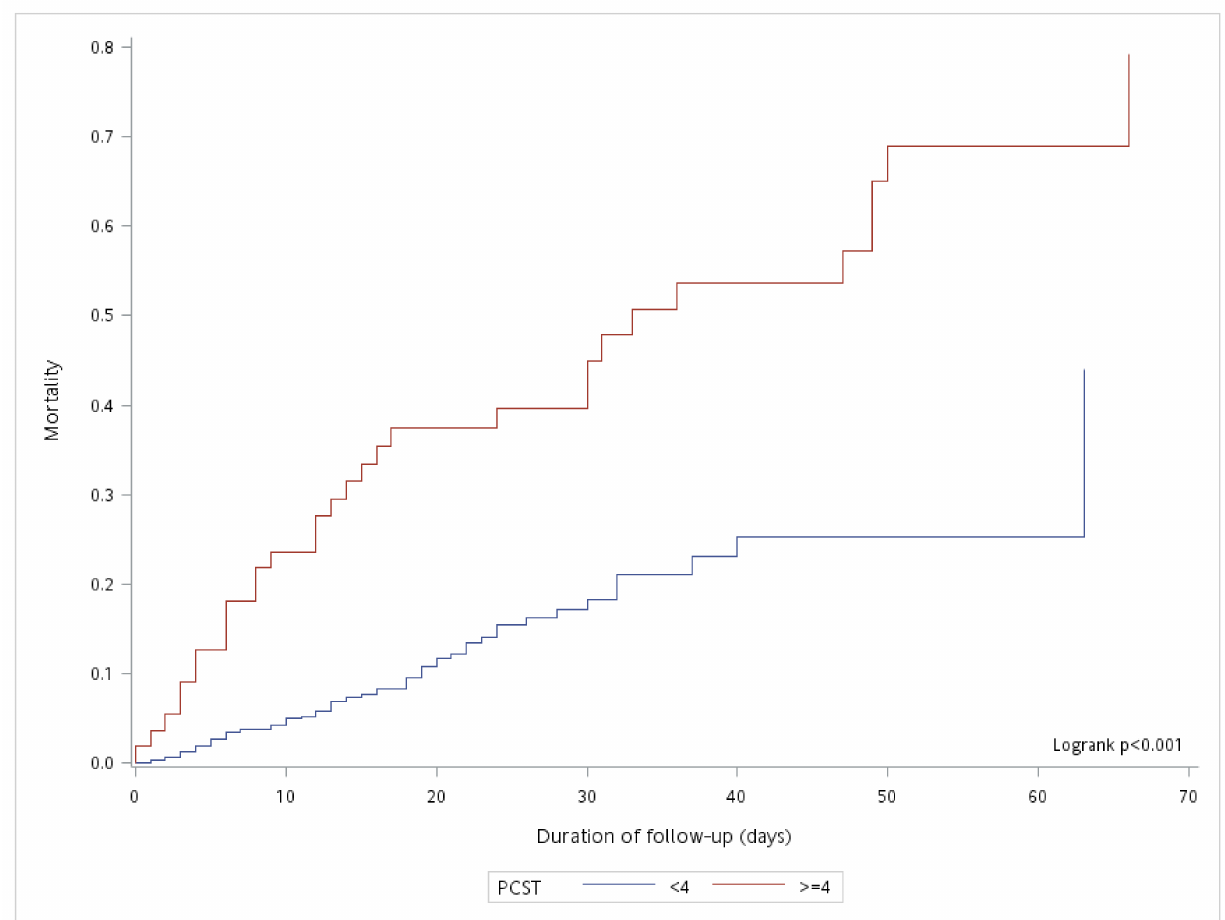
Figure 1. Kaplan–Meier curves for time to the occurrence of death in patients with COVID-19 with PCST scores ≥ 4 and